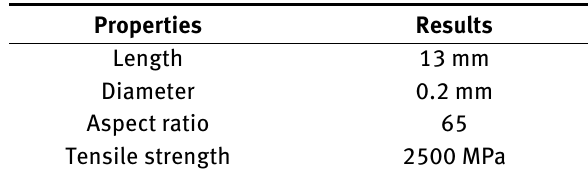
Table 9: Specification of the steel